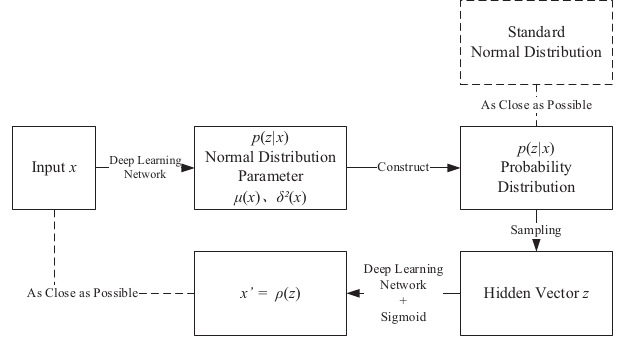
Figure 3. Score matrix fi